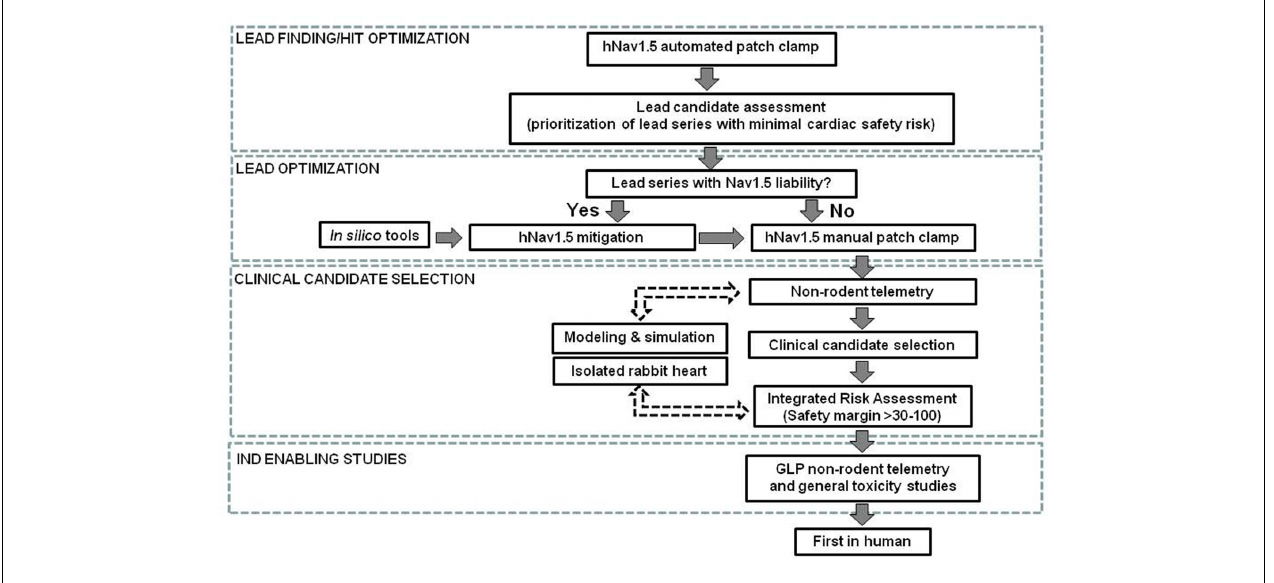
FIGURE 3 | Cardiac sodium channel safety assessment schematic. Non-rodent telemetry includes dog or non-human primates. Safety margins are calculated by dividing hNav1.5 IC 50 , lowest effect concentration in the rabbit heart or free C max for lowest efficacious dose